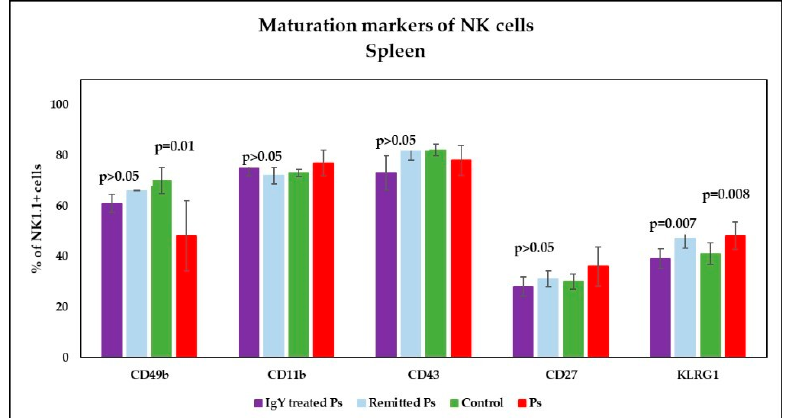
Figure 8. Expression of maturation markers on NK cells in spleen cell suspensions. Expression of CD49b, CD11b, CD43, CD27 and KLRG1 levels on NK1.1 + cells for IgY-treated Ps group (n = 12) (61 ± 3.7; 75 ± 3.1; 73 ± 6.8; 28 ± 3.9; 39 ± 3.9) as compared to naturally remitted Ps group (n = 8) (66 ± 0.2; 72 ± 3.2; 82 ± 4.1; 31 ± 3.1; 47 ± 3.7), control group (n = 8) (70 ± 5.1; 73 ± 1.4; 82 ± 2.3; 30 ± 2.9; 41 ± 4.3) and Ps group (n = 8) (48 ± 13.9; 77 ± 5.2; 78 ± 6; 36 ± 7.8; 48 ± 5.4). The results (% of NK1.1 + cells) are presented as mean ± SD; n = number of mice).